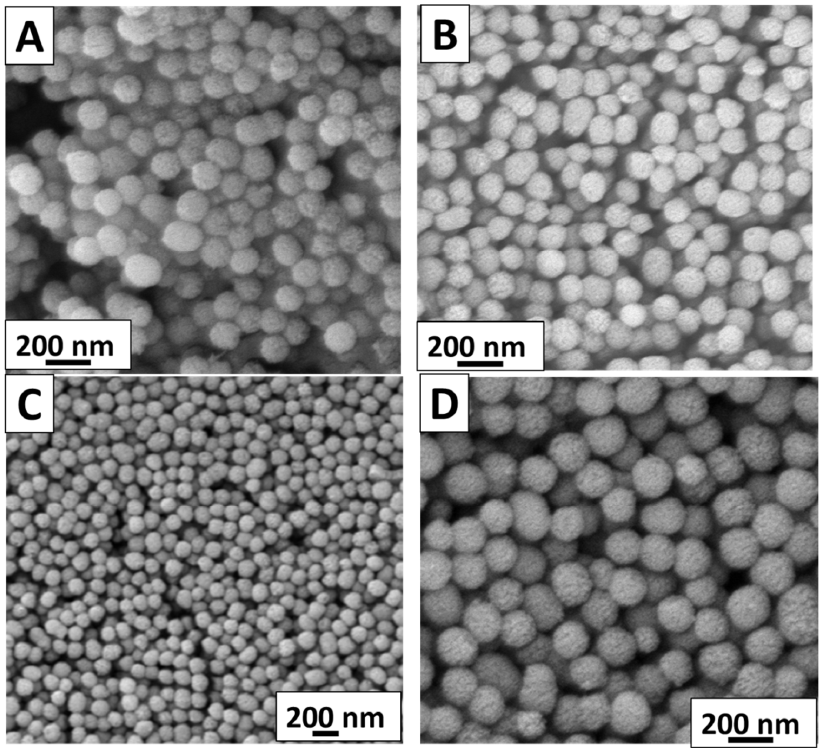
Figure 1. Scanning electron microscopy (SEM) images showing the morphology of the produced nanoparticles: ( A ) pure MBGNs, ( B ) Ag-MBGNs, ( C ) Sr-MBGNs, ( D ) Ag-Sr MBGNs.